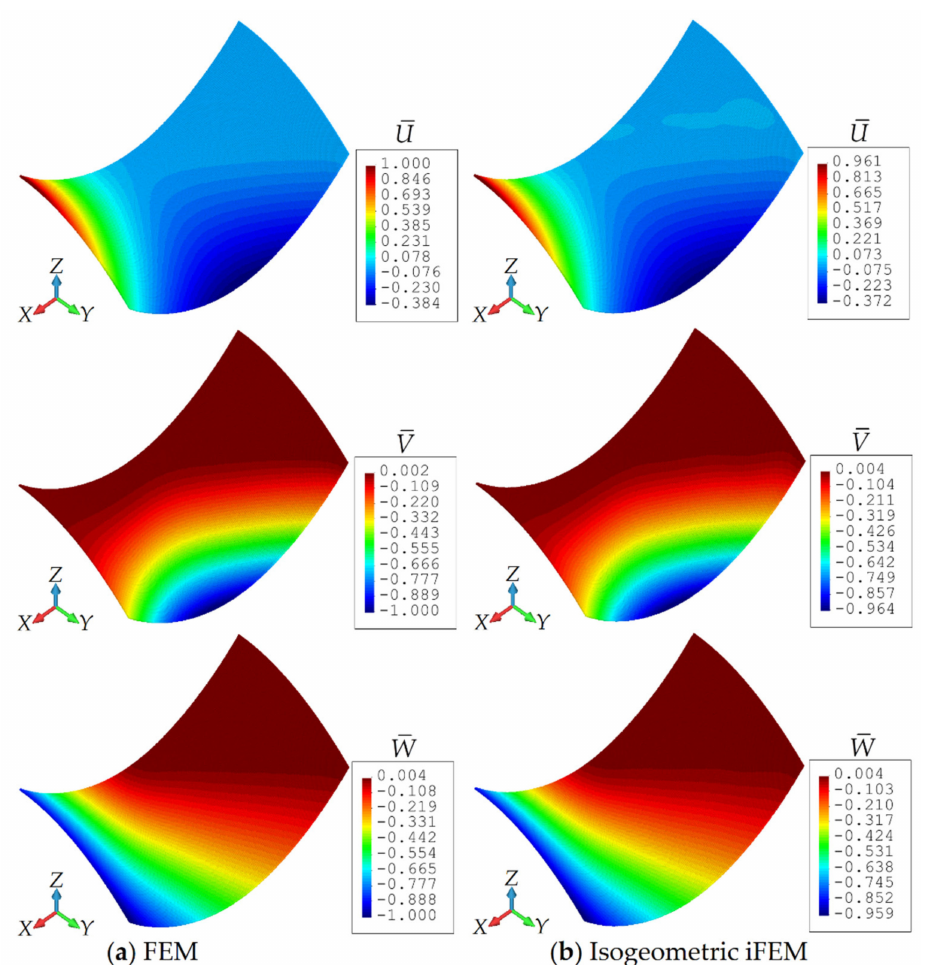
Figure 15. Contour plots of U , V , W displacements for hyperbolic paraboloid: Comparison between ( a ) high-fidelity FEM and ( b ) isogeometric iFEM (n e = 6)